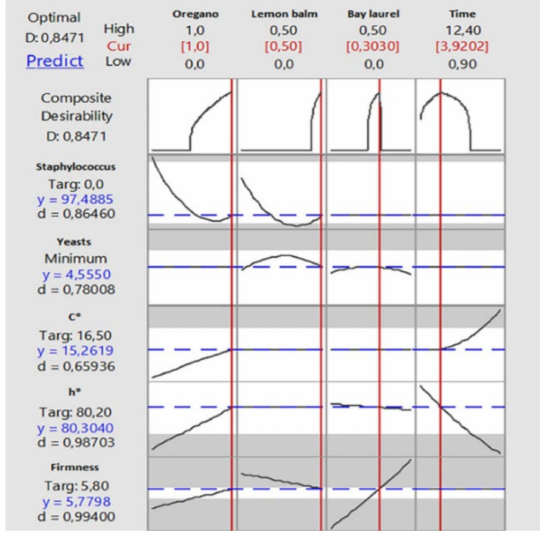
Figure 6. Multiple response optimization plot for growth of Staphylococcus (Y S ) and yeasts (Y Y ), C * (Y C *), h * (Y h *), and firmness (Y F ) (data from Figure 6 in